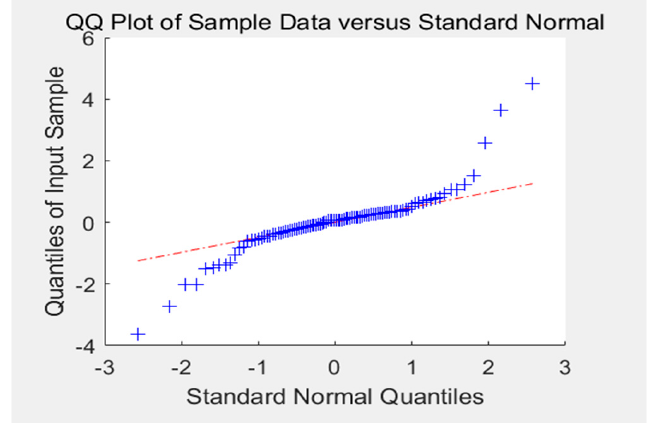
Figure 13. Residual